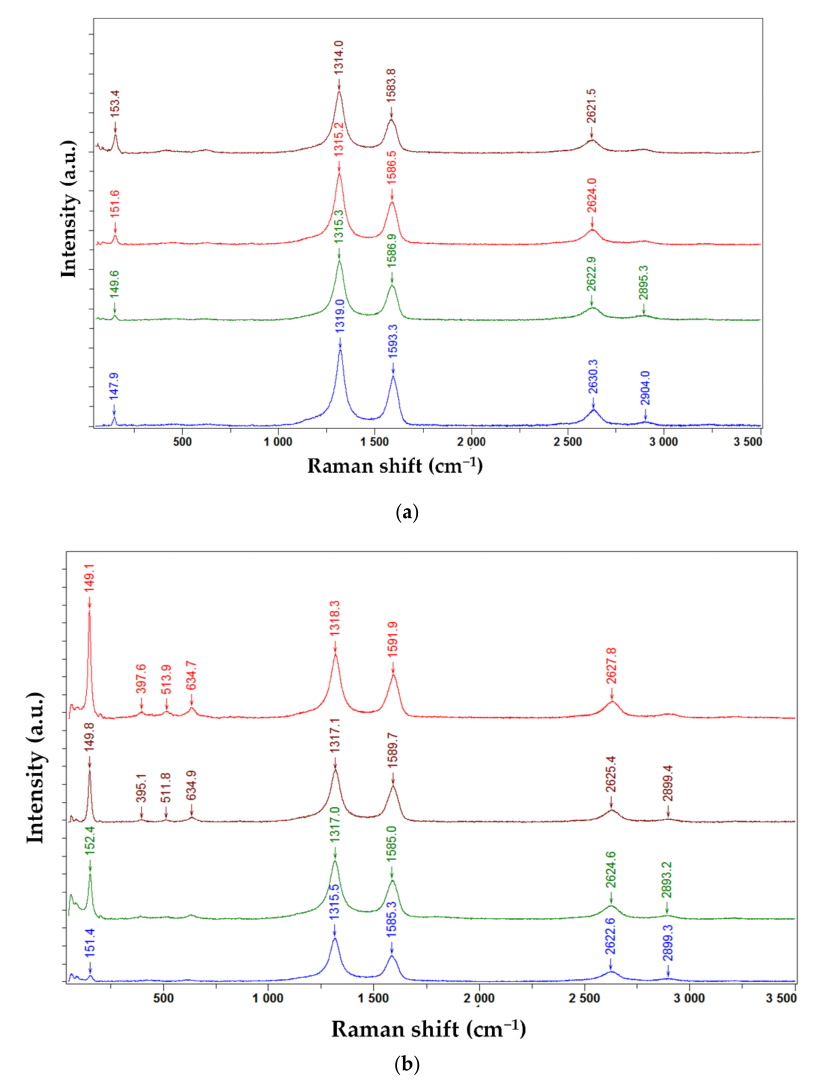
Figure 6. Scanning electron micrographs of the CNHox/TiO 2 /PVP at the 3:1:1 w/w/w ratio: ( a ) × 600,000 magnification and ( b ) × 150,000 magnification.